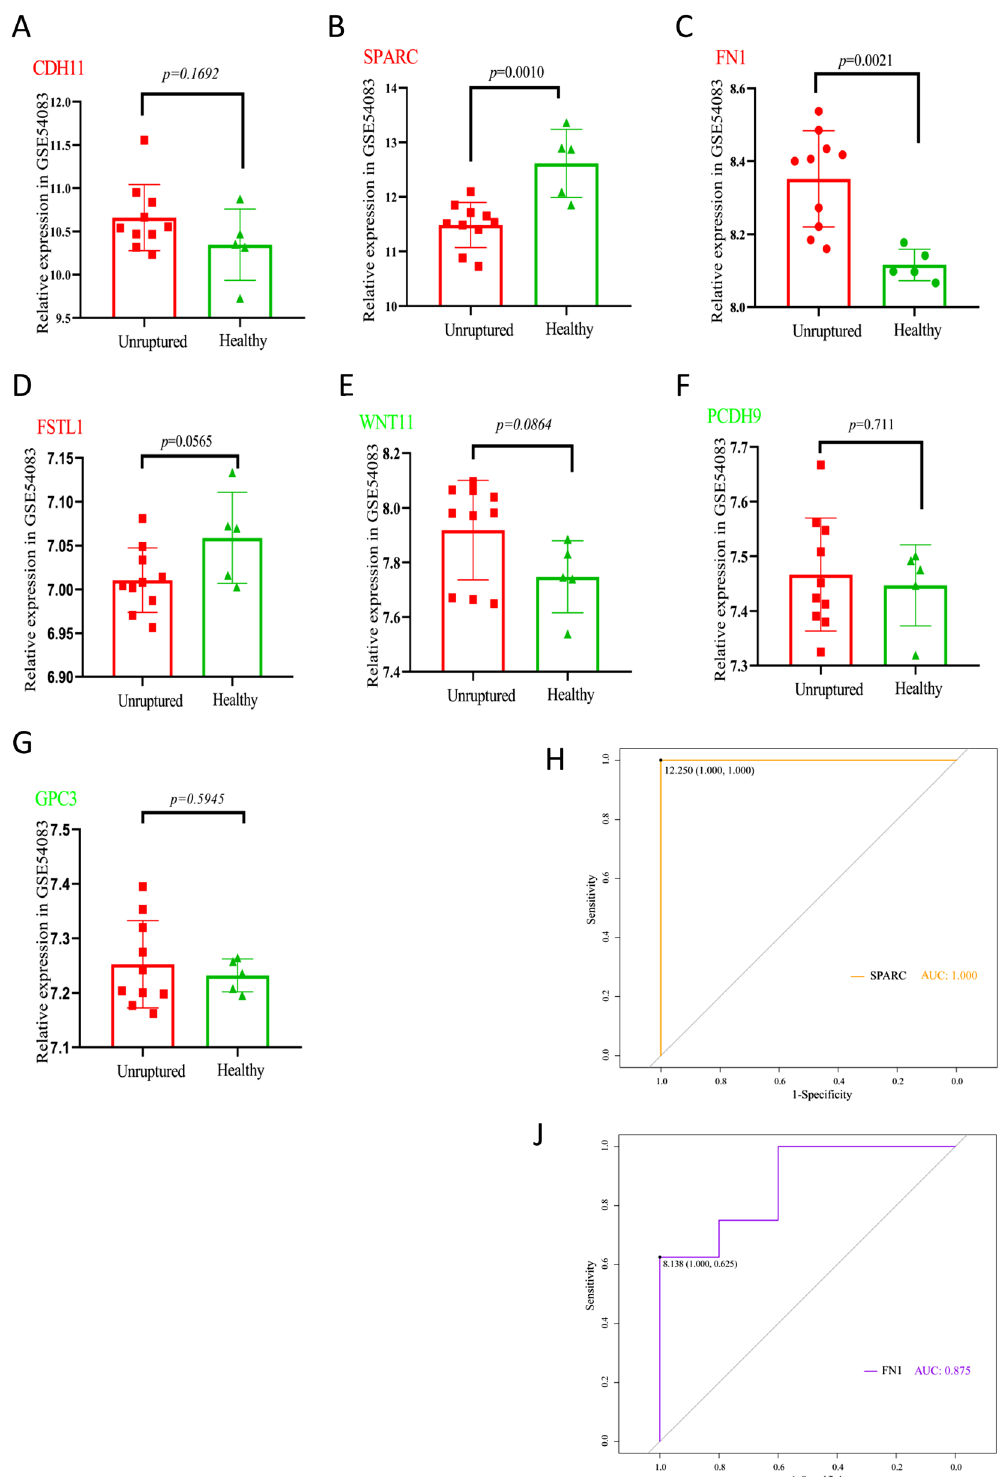
Figure 6. Expression verification of EMT-related key genes. ( A – G ) The above-mentioned seven EMT-related genes ( CDH11, SPARC, FN1, FSTL1, WNT11, PCDH9, and GPC3 ) expressed with relative expression trends in the GSE54083 dataset (unruptured, healthy) were visualized via Graphpad Prism 8.0.0. ( H – J ) Receiver operating characteristic (ROC) curves of ( SPARC, FN1 ), and the area under the ROC curve (AUC) to evaluate the diagnostic value were visualized by R software